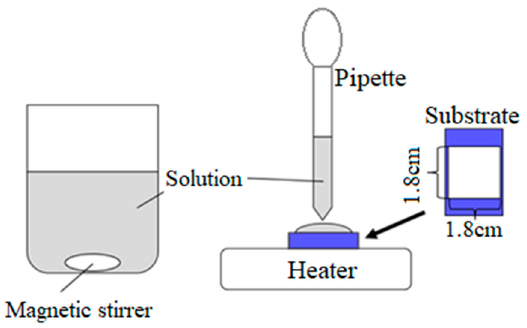
Figure 1. Apparatus of the drop-dry deposition method.